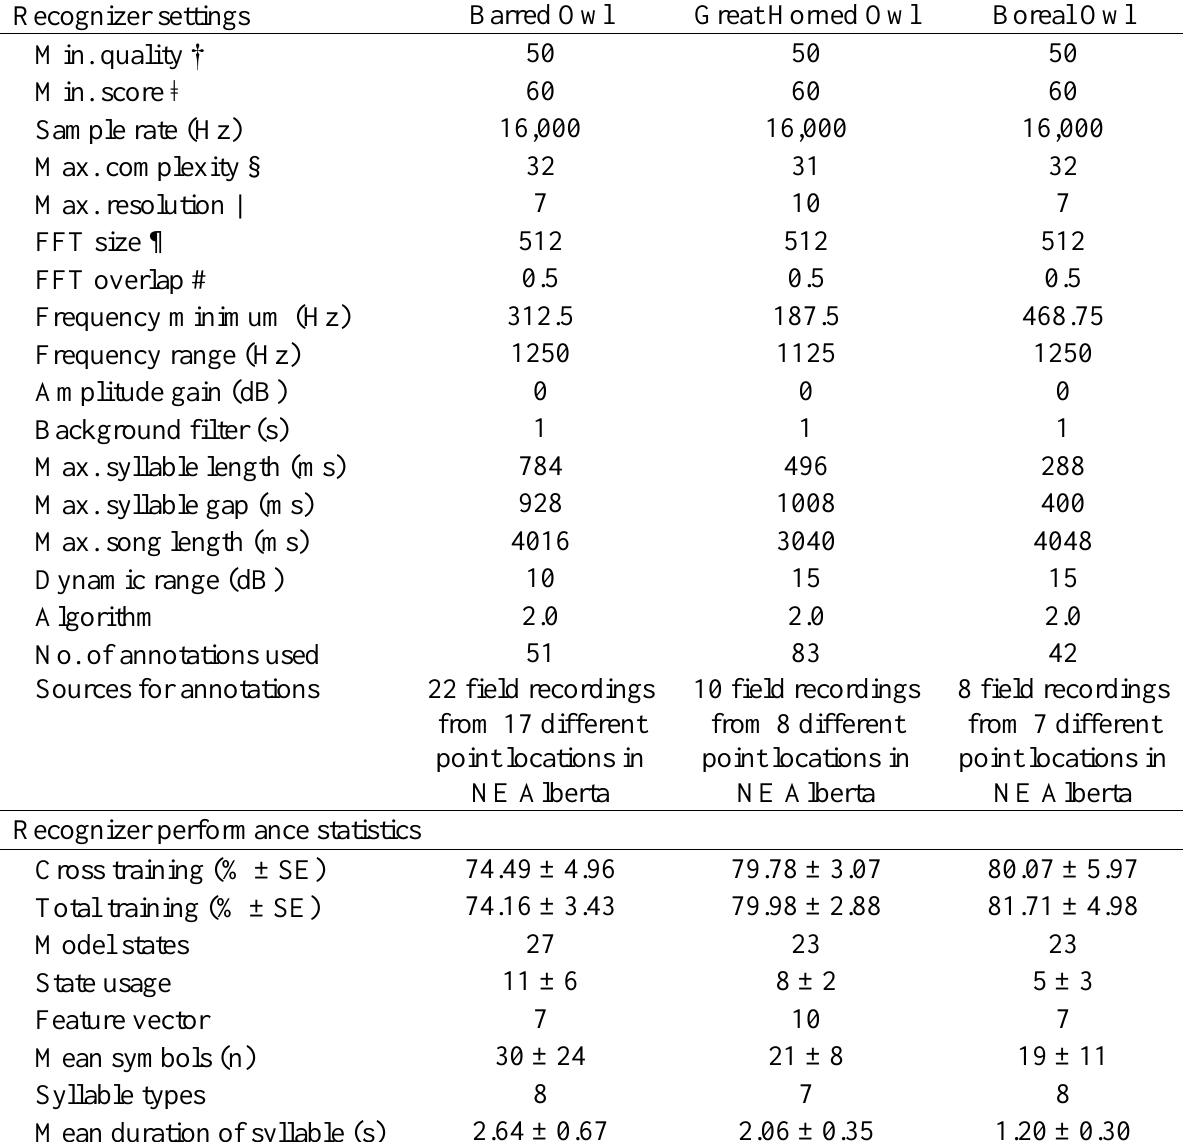
Table A2.1. Details of the settings, annotations, and performance statistics of the automated computer recognizers built in Song Scope (Wildlife Acoustics Inc., Maynard, Massachusetts, USA) to detect calls of Barred Owls ( Strix varia ), Great Horned Owls ( Bubo virginianus ), and Boreal Owls ( Aegolius funereus